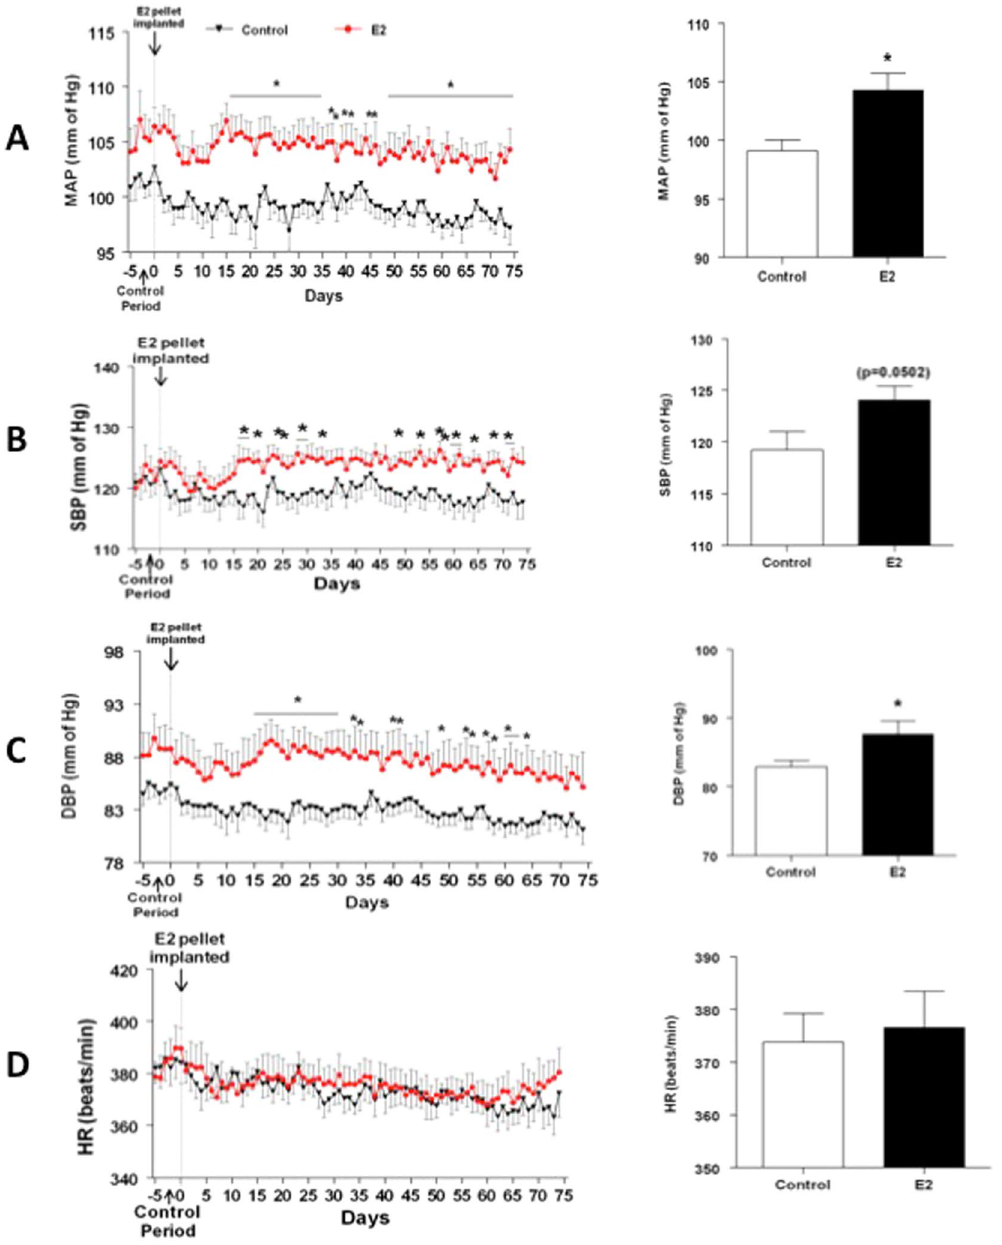
Figure 2. Time course for chronic E2 exposure-induced changes in blood pressure parameters. Line graphs depicting mean arterial pressure (MAP; mmHg) ( A ), systolic blood pressure (SBP) ( B ), diastolic blood pressure (DBP; mmHg) ( C ) and heart rate (HR; beats/min) ( D ): closed red circles represent E2 pellet implanted (20 ng/ day, 90-day slow-release pellets) and closed black triangles represent control rats (n = 7–8/group). Panels on the right: Bar graphs showing the average values of the cardiovascular parameters over the entire observation period. * Denotes significant difference (p < 0.05) from control